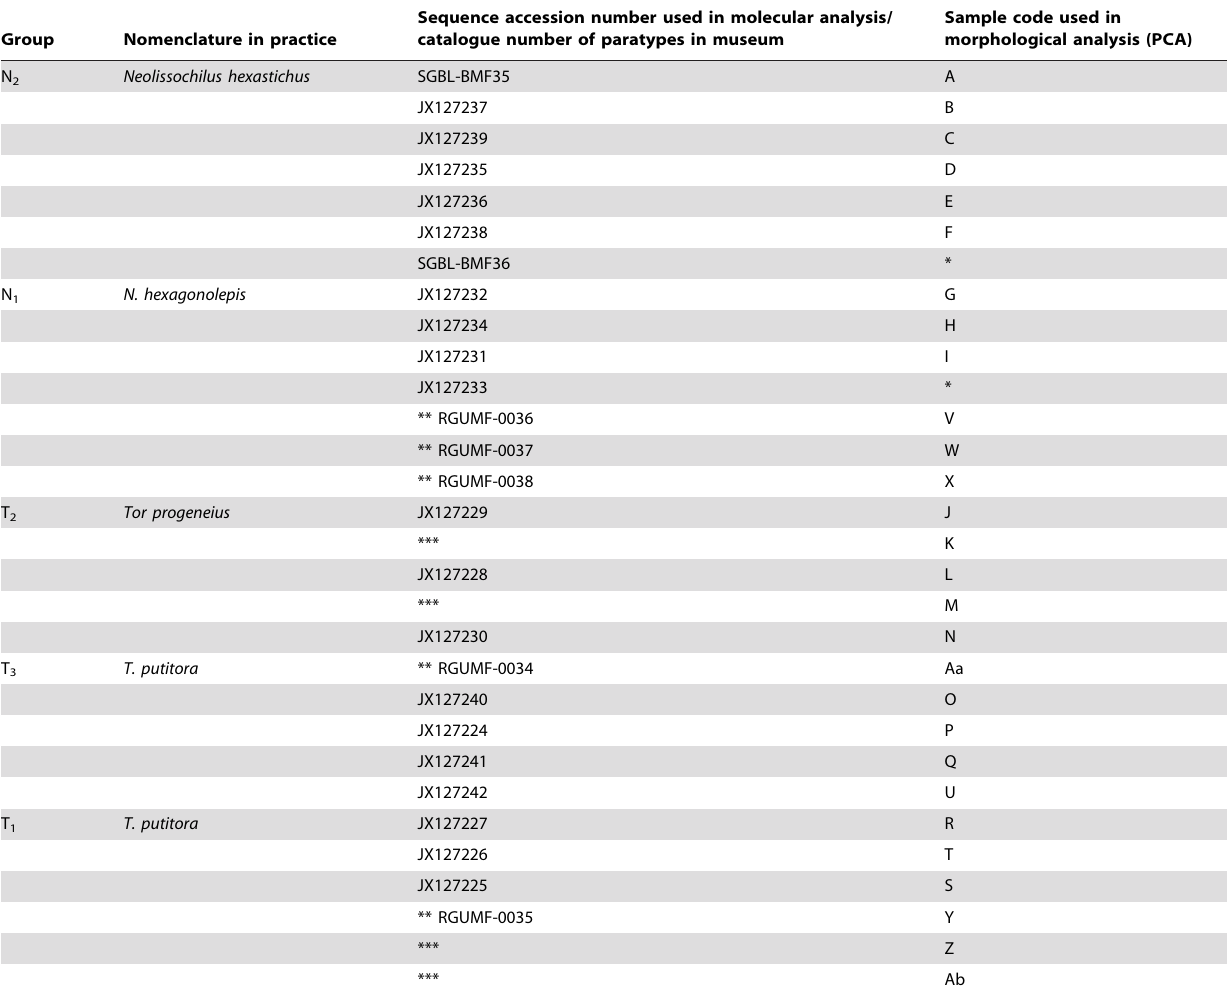
Table 1. Morphological grouping of the studied organisms along with the corresponding